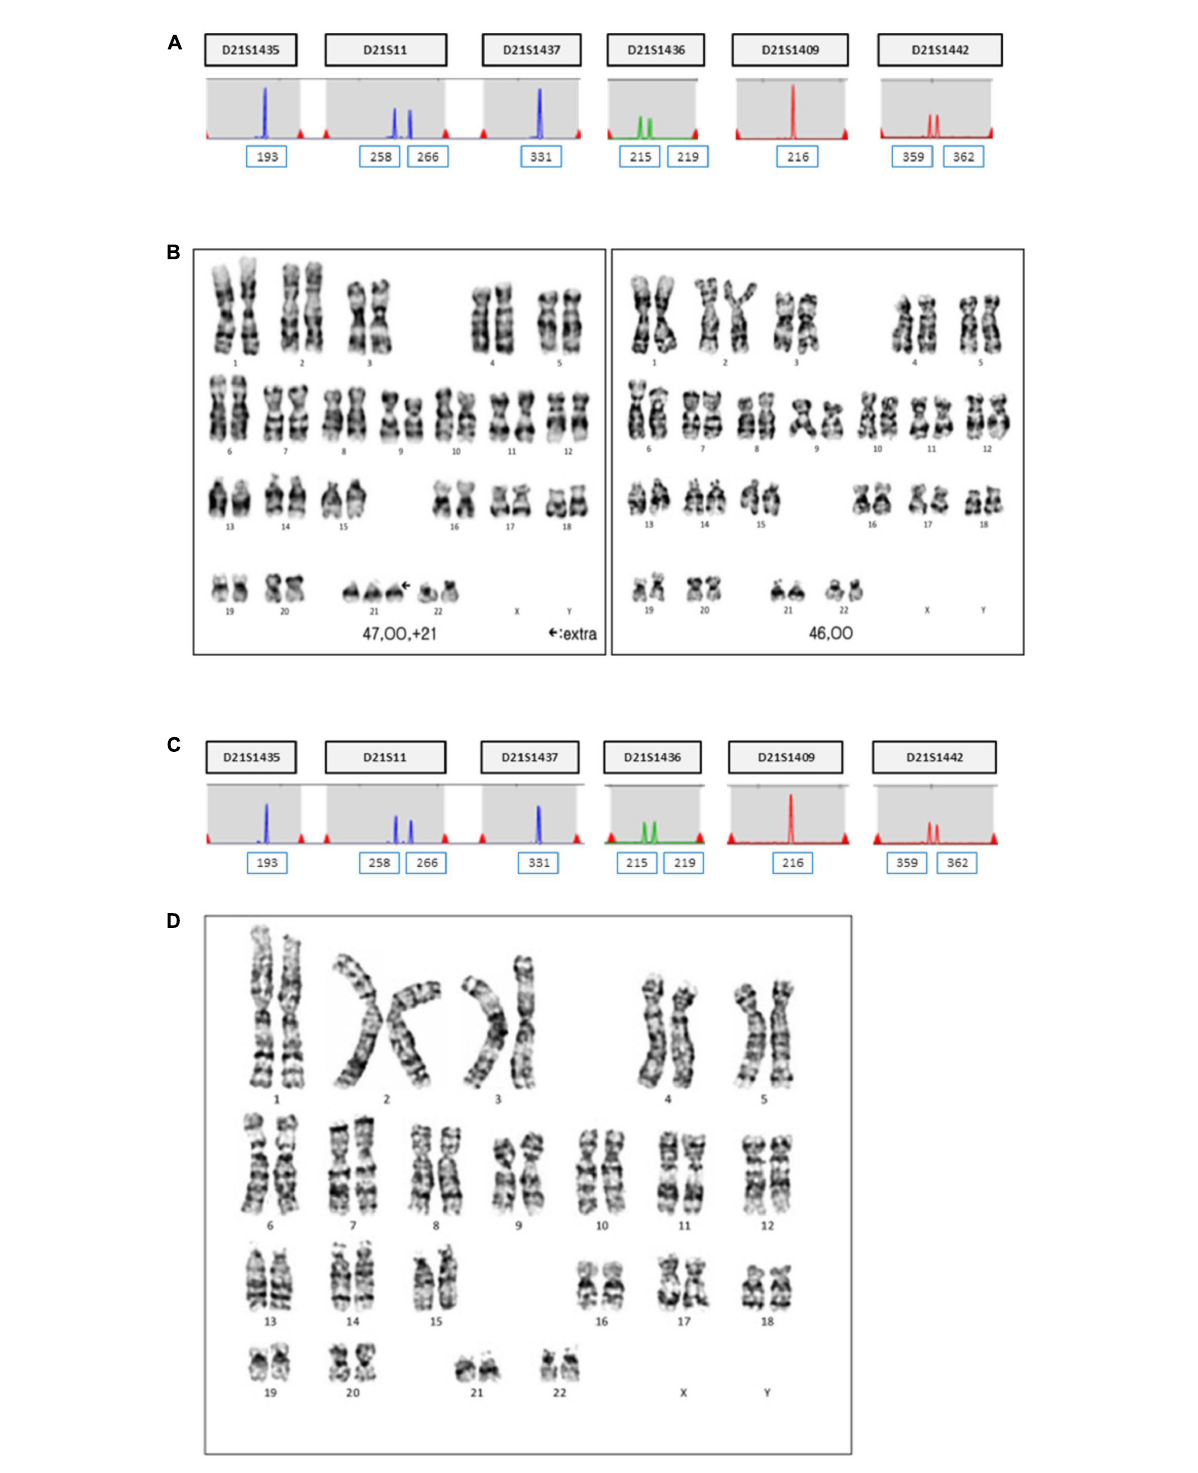
FIGURE2 QF-PCR and conventional karyotyping results in case 1. (A) QF-PCR analysis for chromosome 21 of uncultured chorionic villi. (B) Conventional karyotype analysis of uncultured chorionic villi; 47, XX, +21[11]/46, XX [39]. (C) QF-PCR result for chromosome 21 of uncultured amniocytes. (D) Conventional karyotype analysis of cultured amniocytes; 46,